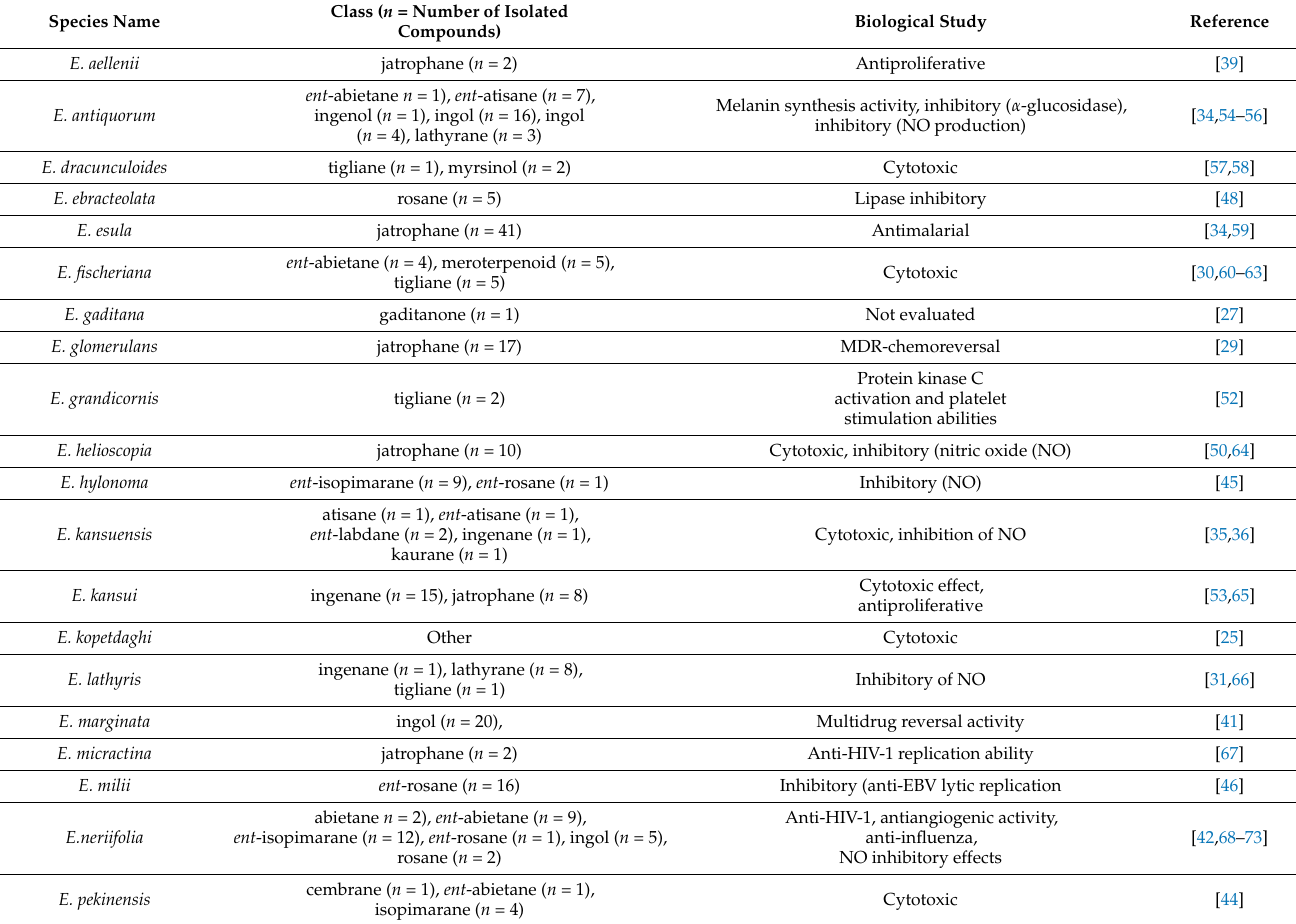
Table 1. Occurrence of Euphorbia diterpenes and their reported biological